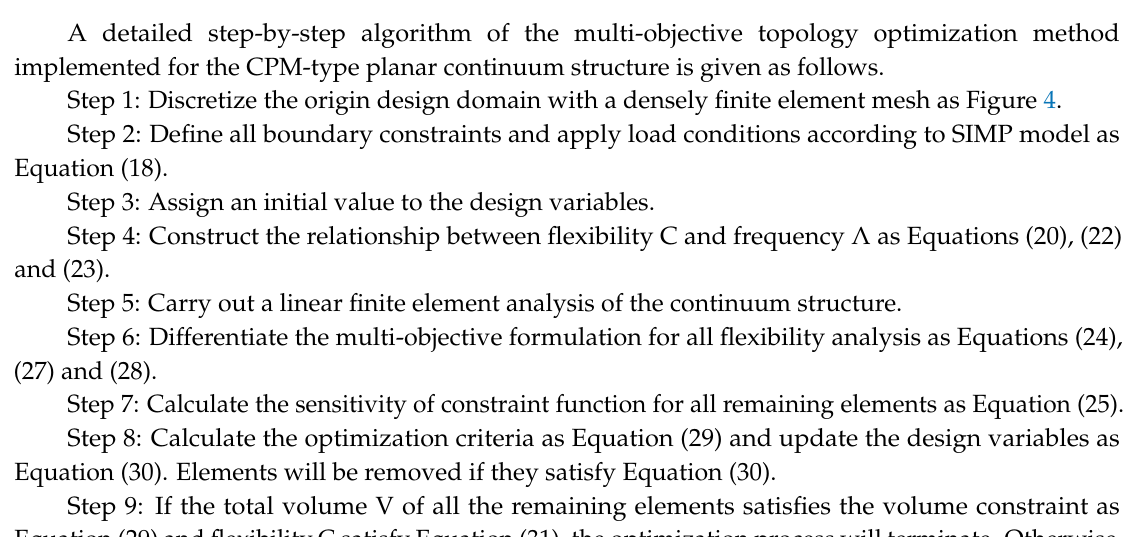
Figure 4. Continuum structure of preprocessing topology optimization model.